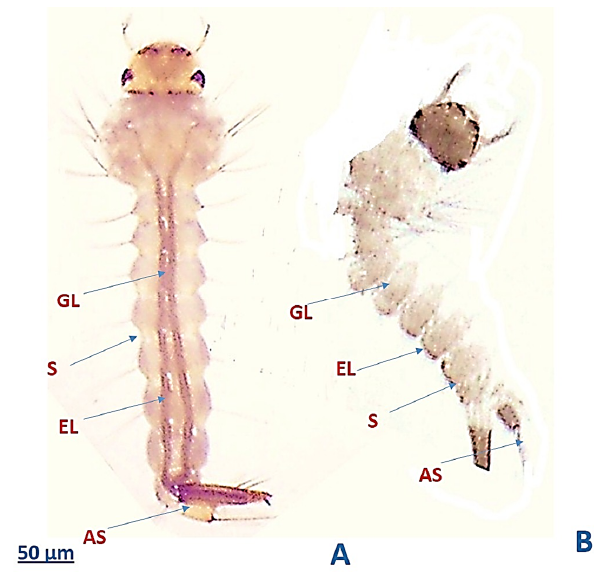
Figure 7. Photo-micrographic analysis of fourth instar larvae of Ae. aegypti ( A ) control larvae and ( B ) My-It-treated larvae. (GL)—gut lumen; (S)—segments; (AS)—anal segments; (EL)—epithelial layer.